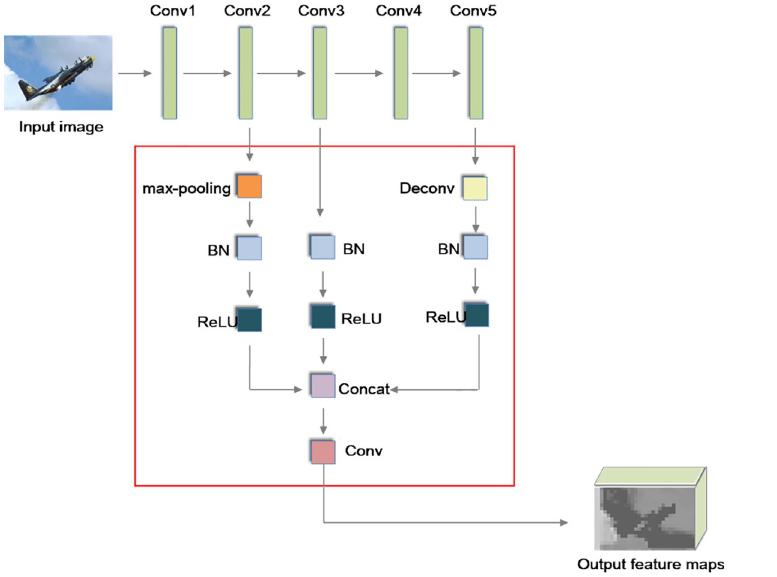
Fig 4. The network of the synthesized feature sampling strategy.